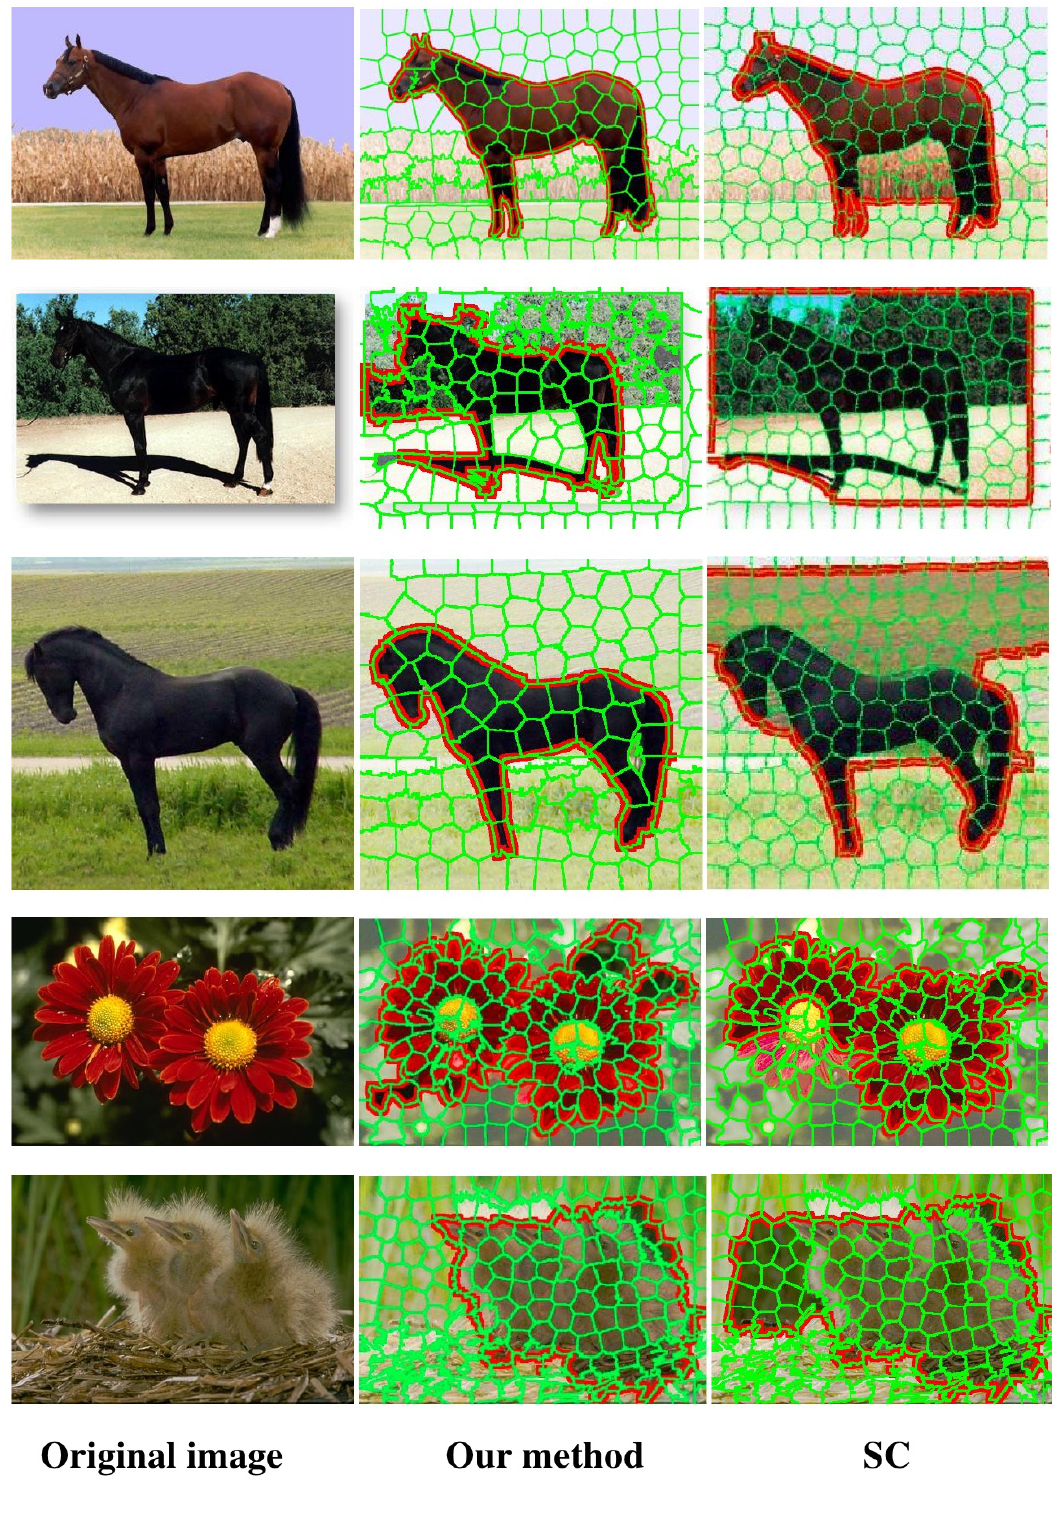
Figure 4: Qualitative results. We compare our results (middle) to superpixel closure algorithm (SC) (right). Left column is the original images. Top 3 rows are from WHD, and bottom 2 rows are from BSDS5000